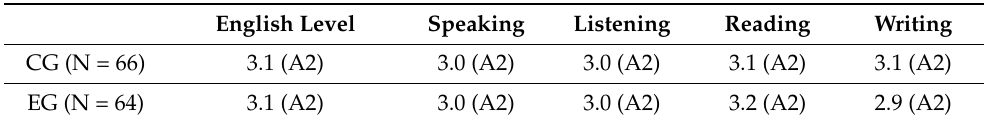
Table 1. Self-perceived language level according to the CEFR Framework: 1 = A0, 2 = A1, 3 = A2, 4 = B1, 5 = B2, 6 = C1, 7 =